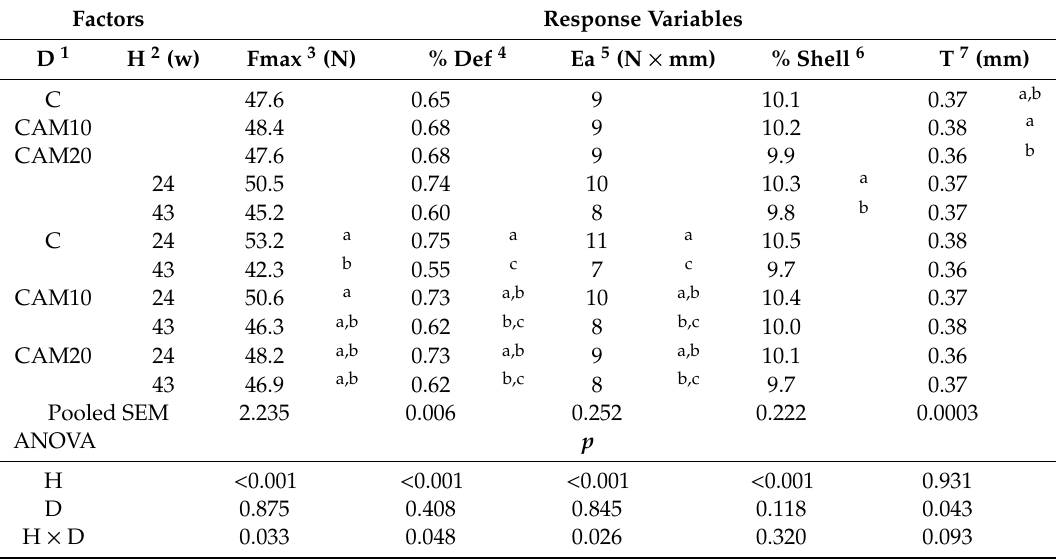
Table 6. Effect of hen age and different camelina cake level in the diet on compression test response variables (Rupture Force, Specific deformation, and Rupture Energy), and shell traits (shell percentage and thickness) of eggs with shape index 78.5–79.5. Control diet (C) and camelina diets (CAM10 and CAM20). Factors Response